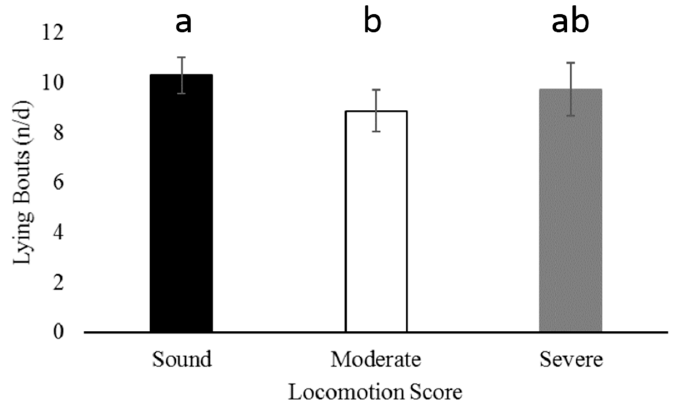
Figure 3. Sound cows had higher daily lying bouts compared to moderately lame cows ( p = 0.01). Mean daily lying bouts did not differ between sound cows and severely lame cows ( p = 0.54) or between moderately lame cows and severely lame cows ( p = 0.37). Differences between sound, moderately lame, and severely lame cows are designated by superscripts “a” and “b.” Overall, cows spent 51.3 ± 1.1% daily lying time on their left side which did not differ from 50%